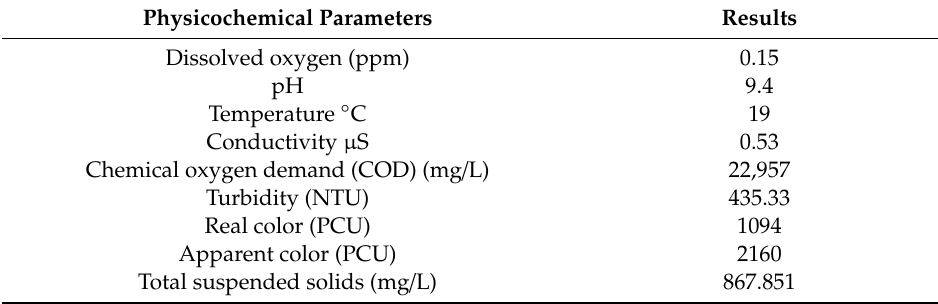
Table 3. The physicochemical parameters of the wastewater before the coagulation–floculation processs with MAT.